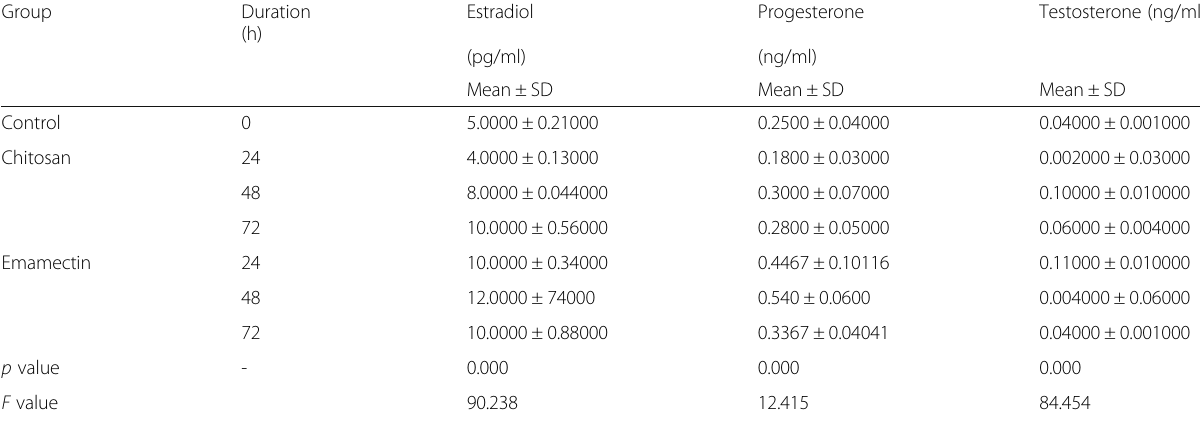
Table 3 Effect of LC 50 of chitosan and emamectin on the level of sex steroidal hormones of Eobania vermiculata using a thin-layer film